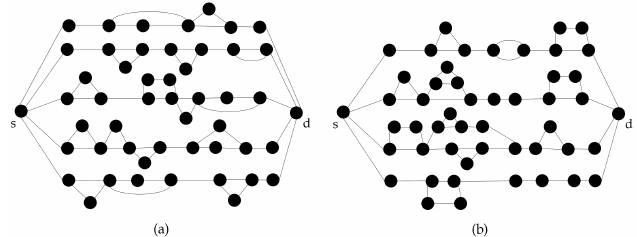
Figure 6. The topologies used in the probabilistic example. ( a ) is the low-clustered topology. ( b ) is the high-clustered topology.